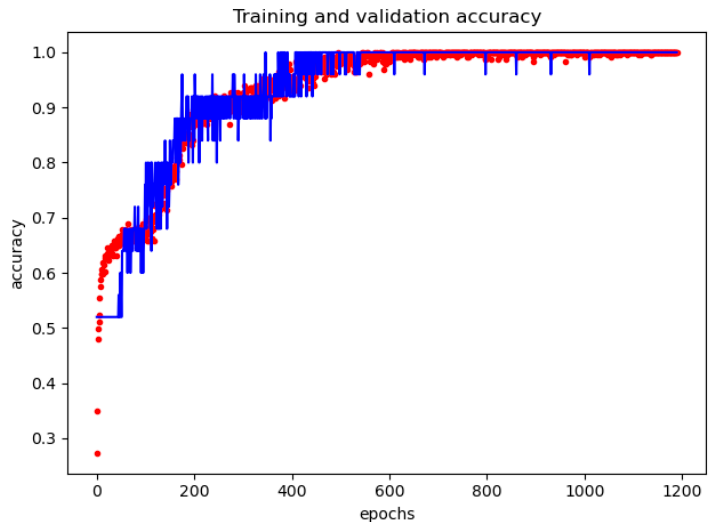
Figure 9. Evolution with the epochs of the accuracy during the training phase on the training set (red dotted curve) and the validation set (blue solid line) for the first fold.